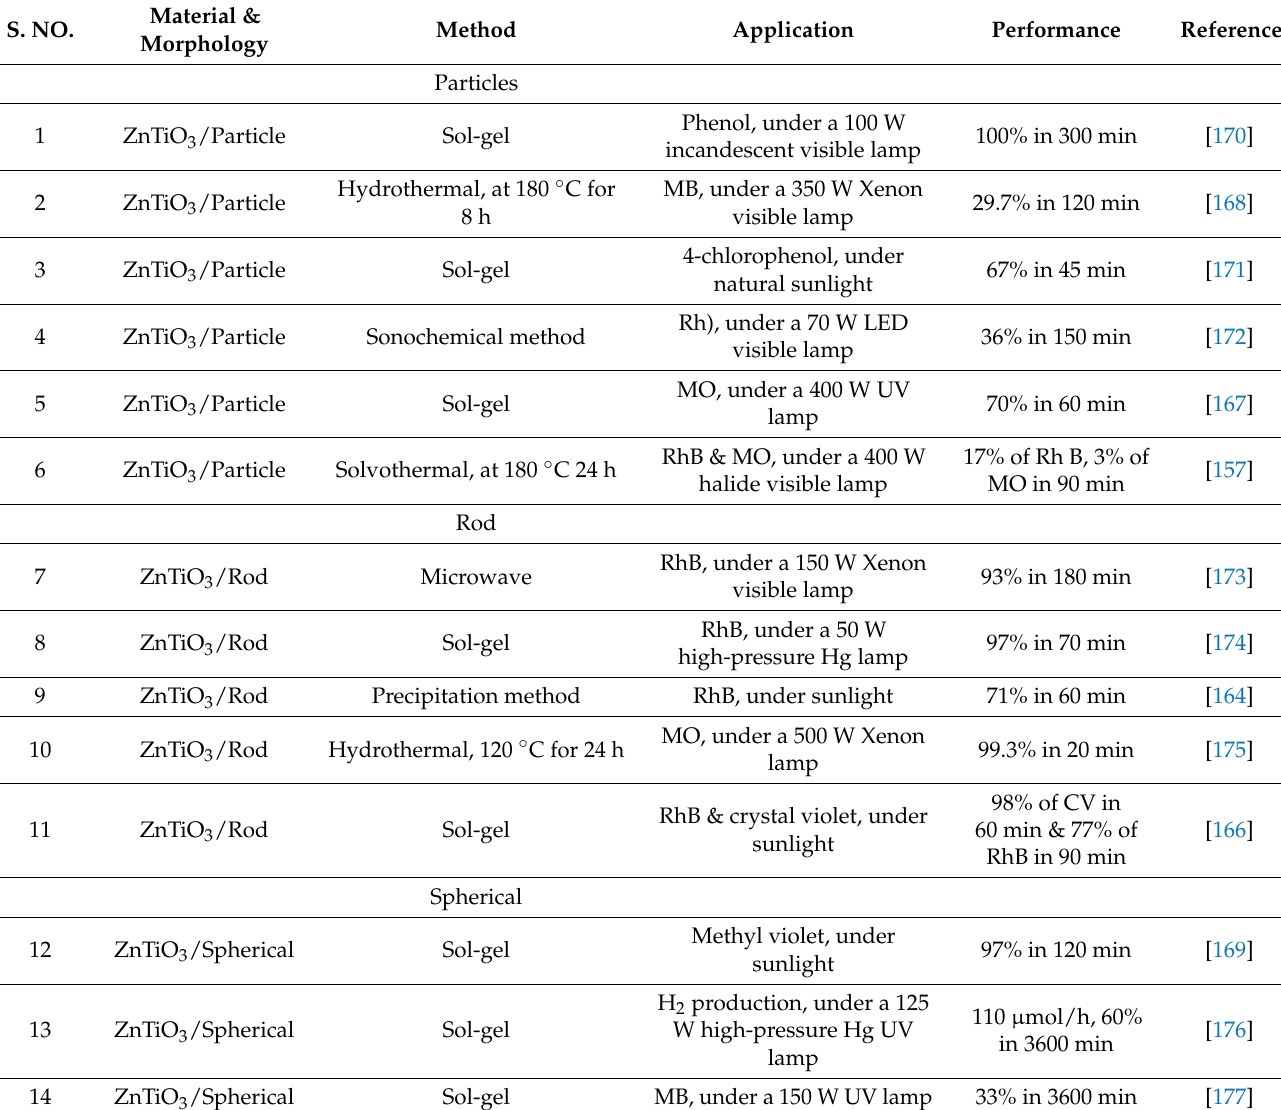
Table 5. Details of different morphologies of nanostructured ZnTiO 3